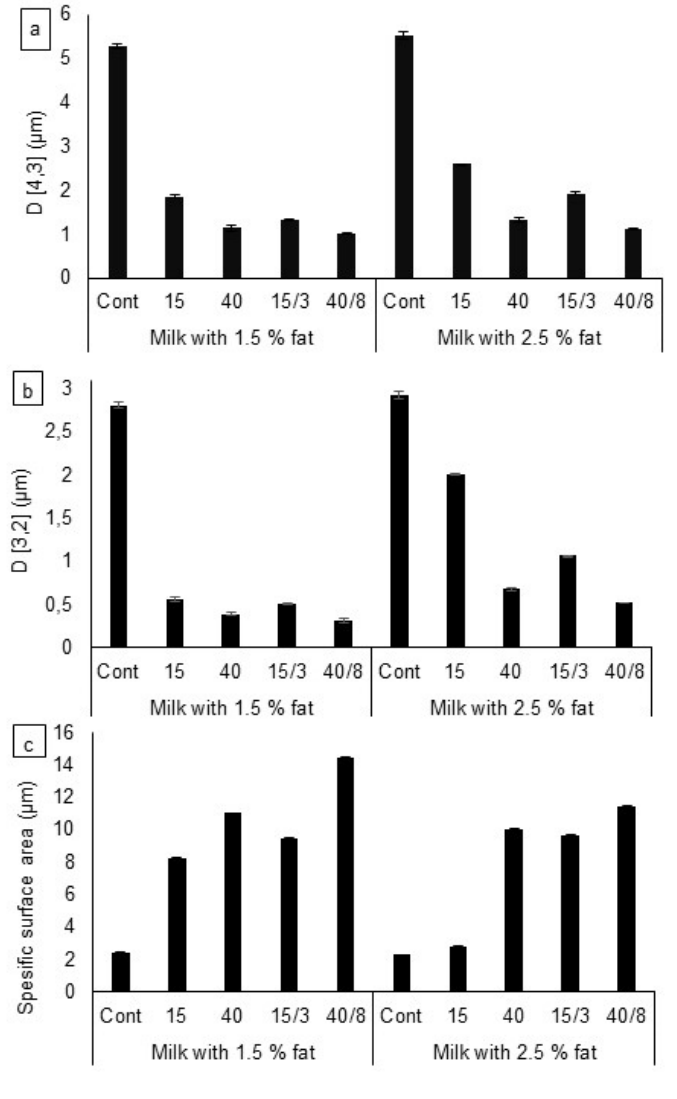
Figure 2. (a) D [4,3], (b) D [3,2] and (c) specific surface area values of the ayran samples. The bars represent mean values, and the error bars represent standard error of the